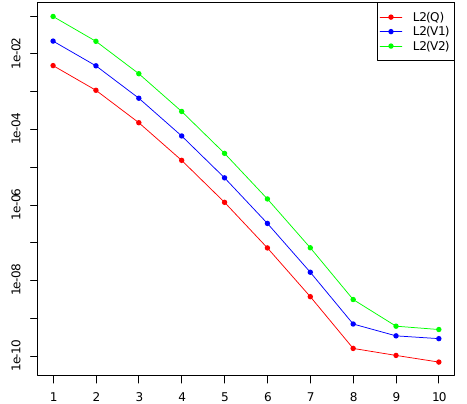
Figure 5. Proper orthogonal decomposition (POD) error in L2 norm. x -axis: number of modes, y -axis: error in L2 norm, in logarithmic coordinates.